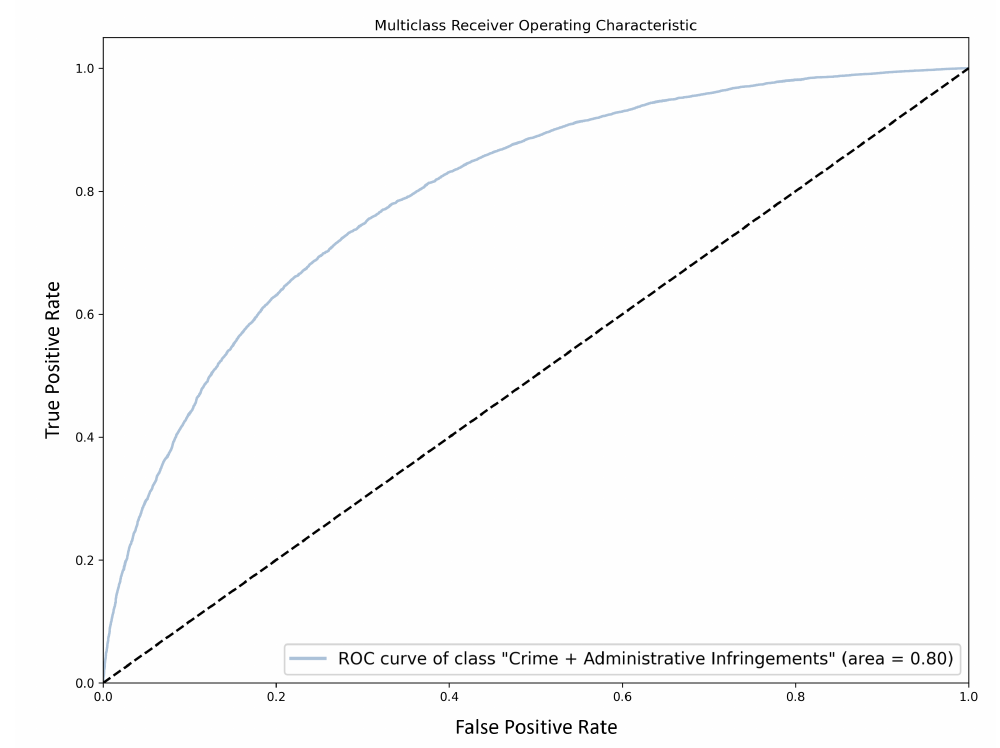
Figure 3. ROC curve for infraction severity prediction using SVM (2-class